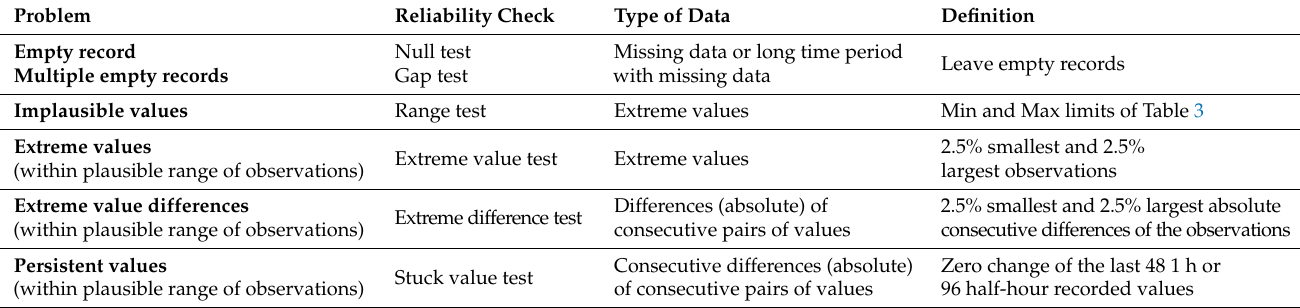
Table 4. The quality tests applied in the data recorded by the automatic stations of